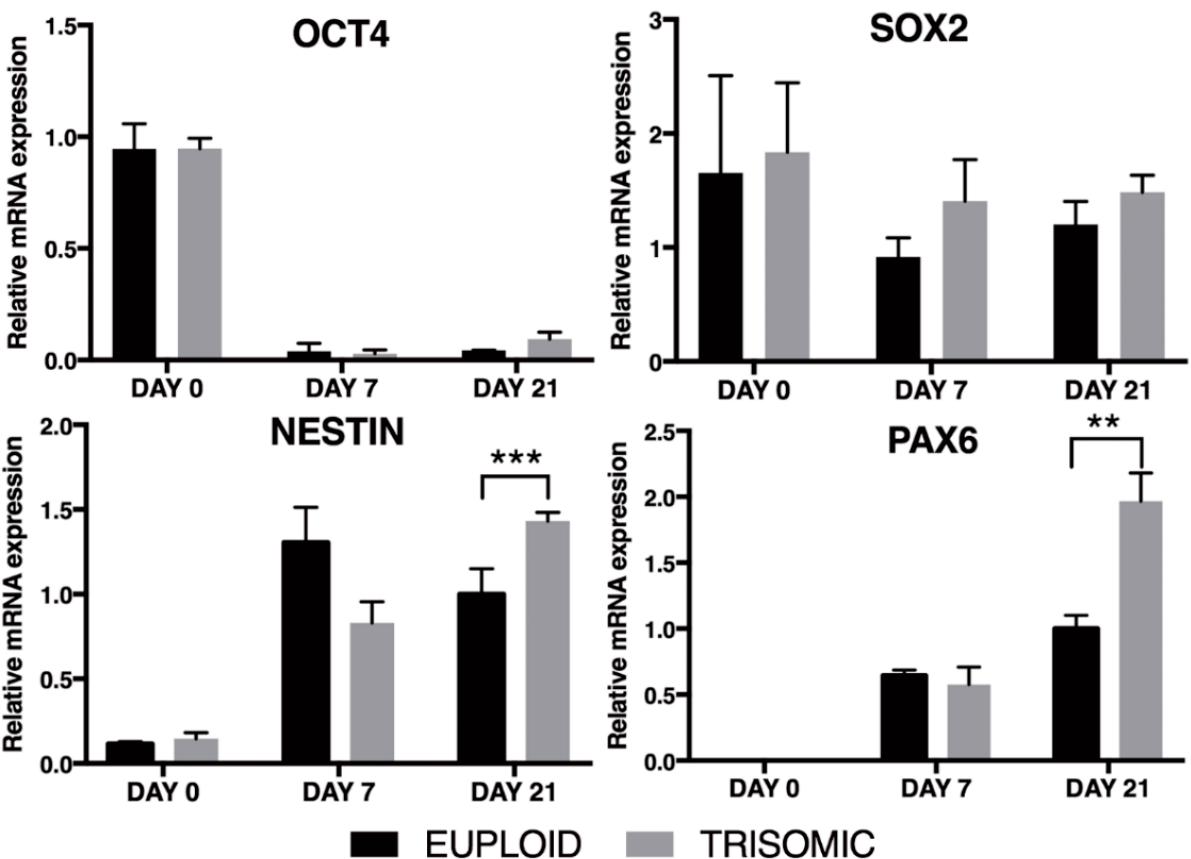
Figure 4. qRT-PCR analysis of stemness and neural differentiation markers. The stemness, OCT4 , and neural differentiation markers, NESTIN , SOX2, and PAX6 , were analyzed by qRT-PCR in euploid and trisomic cells, at different times of differentiation in culture. mRNA expression is normalized to a reference gene ( ACTIN ). Results are expressed as mean values ± SEM of at least four independent experiments for each cell line. ** p < 0.01; *** p < 0.001. Values of trisomic cells represent the average of the two trisomic clones